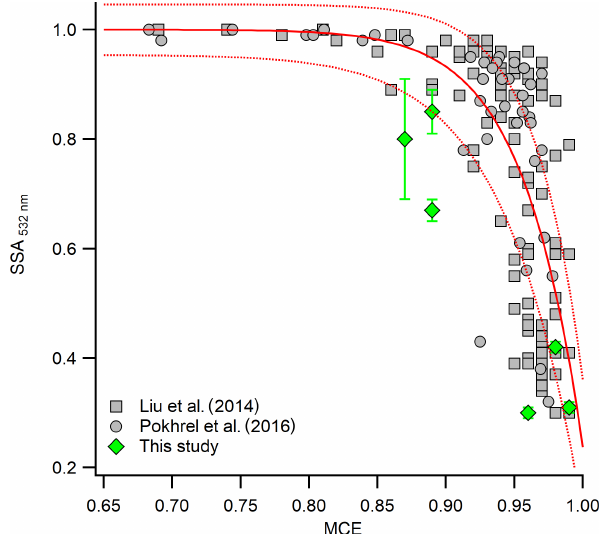
Figure 5. SSA of 400nm size-selected aerosol at 532nm as a func- tion of MCE under different combustion temperatures. Gray sym- bols are the SSA of bulk aerosol from previous studies (Liu et al., 2014; Pokhrel et al., 2016). Solid and dashed red lines are the best fit and the uncertainty bounds proposed by Liu et al.